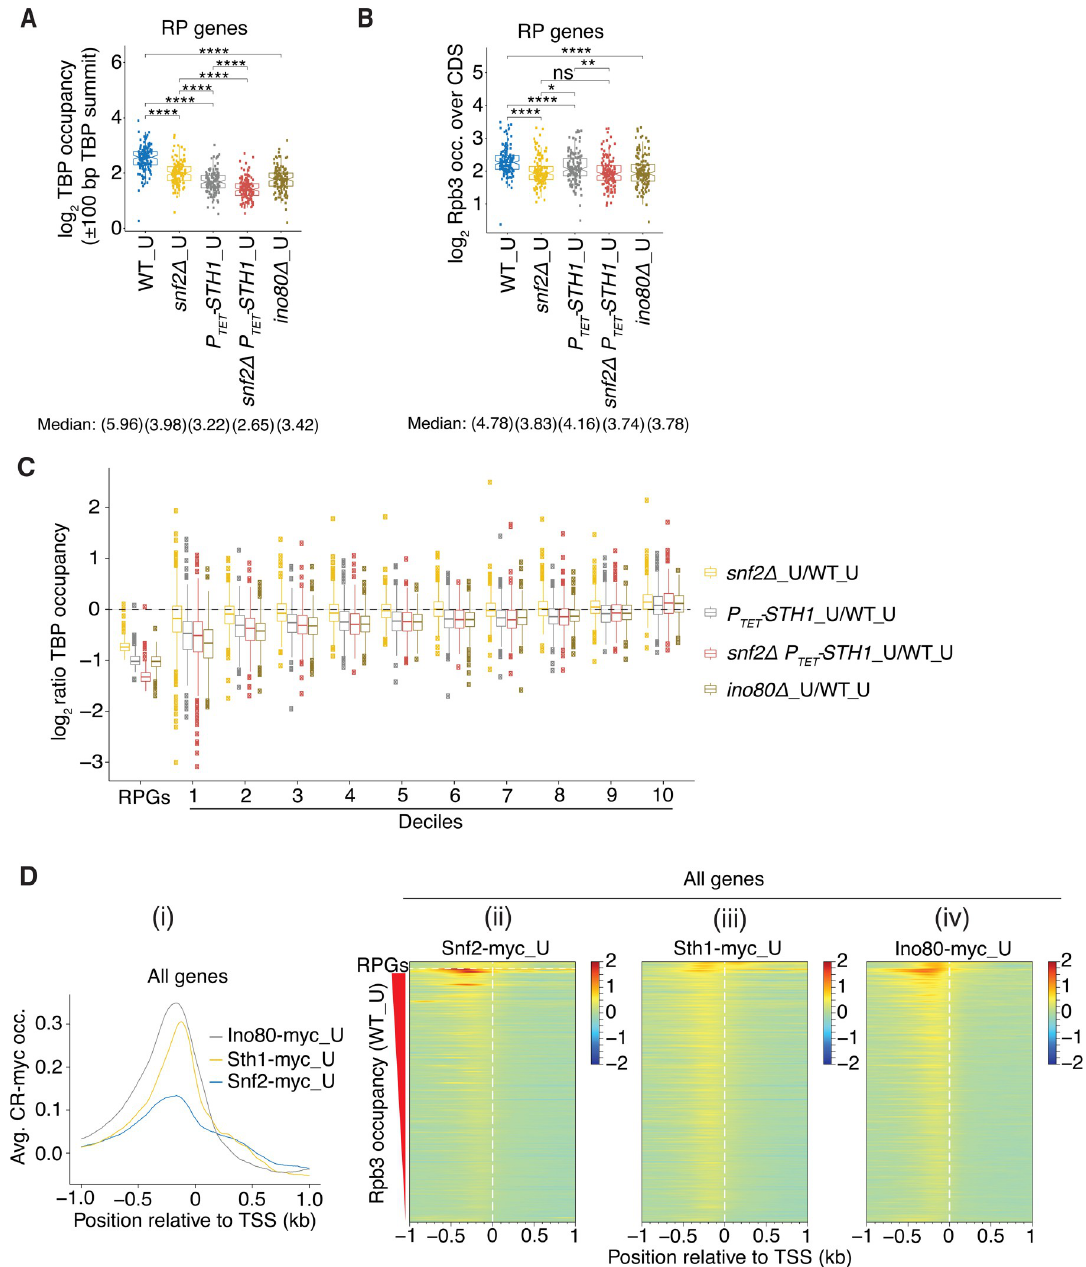
Fig 6. RSC and Ino80C act broadly whereas SWI/SNF functions mainly at highly expressed genes to promote TBP recruitment. (A-B) Notched box plots of log 2 TBP occupancies within ± 100 bp of TBP peak summits (A) and log 2 CDS Rpb3 occupancies (B) at all RP genes in WT or the indicated mutants, in uninduced cells. (C) Notched box plots of log 2 ratios of TBP occupancies in the indicated mutants vs. WT in uninduced cells for RP genes and Deciles 1–10 of all genes arranged in descending order of Rpb3 occupancies in WT_U cells. (D) (i) Averaged corrected Ino80-myc_U, Snf2-myc_U, and Sth1-myc_U occupancies aligned to the TSSs of all genes. (ii)- (iv) Heat map depictions of corrected occupancies of (ii) Snf2-myc_U, (iii) Sth1-myc_U, and Ino80-myc_U (iv) at RP genes (at the top) and all other genes sorted in decreasing order of WT_U Rpb3 levels, color-coded as indicated on the right.